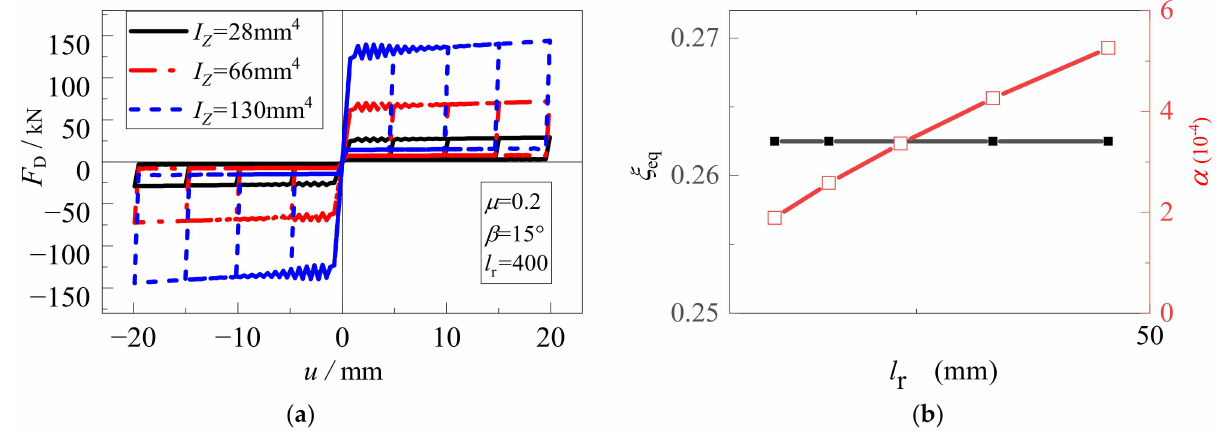
Figure 10. Effects of I Z on BPSCFD: ( a ) Force displacement relationship; ( b ) ξ eq and α